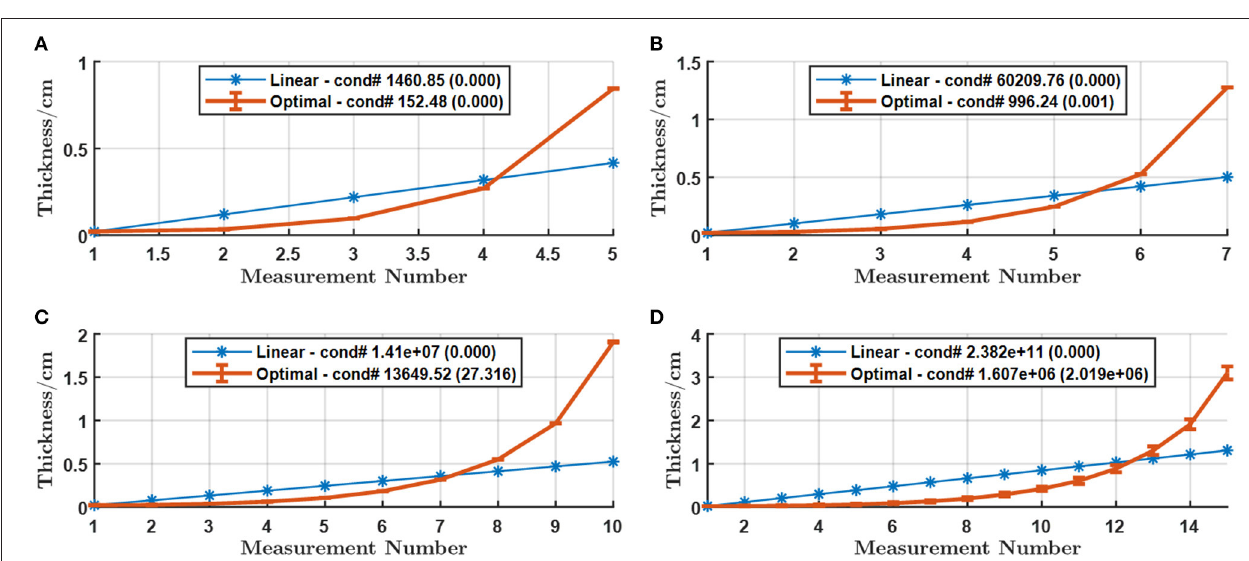
FIGURE 5 | Optimal thickness arrangement against the best linear arrangement for (A) M [0.02, 10] cm. The error-bars in the curve stand for the standard deviation of the thickness while the number in parentheses in the legend is the standard deviation of the condition number for 30 repetitions.